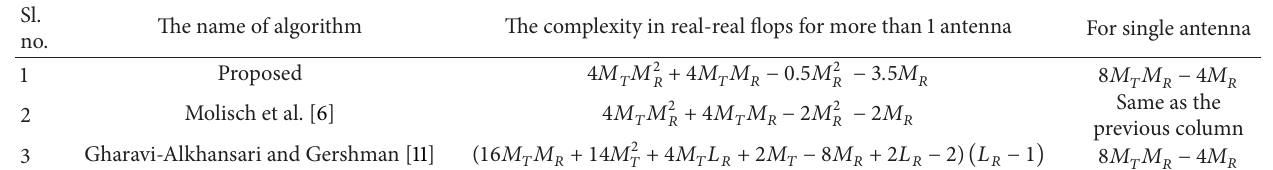
Table 3: Complexity in real-real flops for the proposed and other algorithms